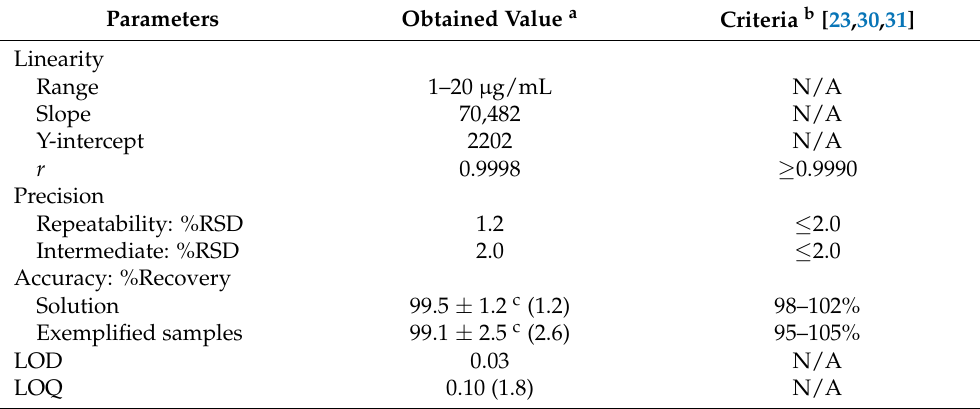
Figure 1. HPLC chromatogram of ganciclovir standard solution at 10 µg/mL under the optimal HPLC condition. An inset illustrates the enlarge view of the chromatogram. Table 2. Method validation data.